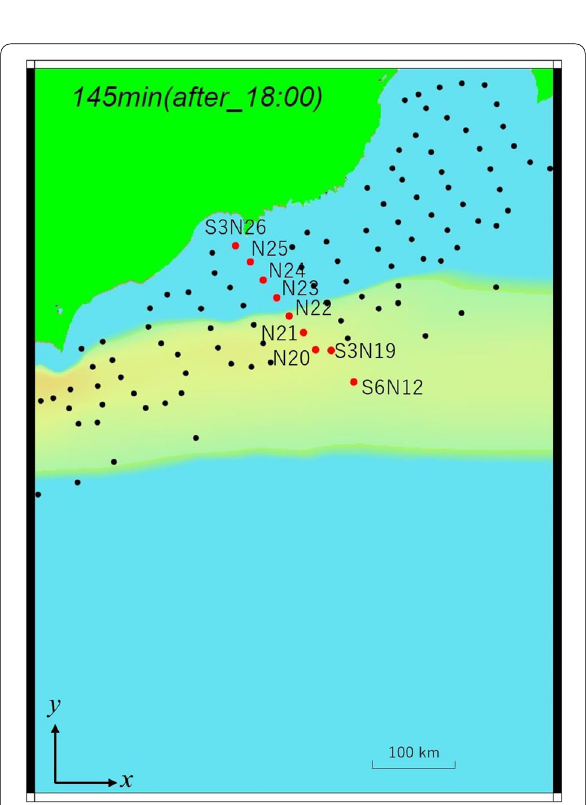
Fig. 3 A snapshot of an air–sea coupled computed tsunami at 145 min after 18:00. Circles represent the locations of ocean-bottom pressure sensors used in this study. Red circles represent the sensors where observed and computed waveforms are compared in Fig.